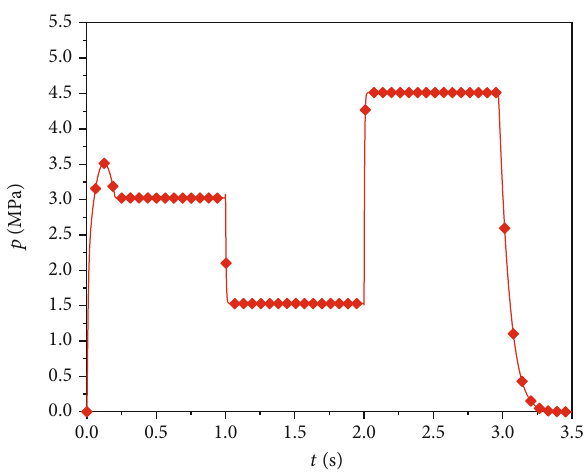
Figure 15: The pressure evolution in the combustor with the variation of pasty propellant fl ow